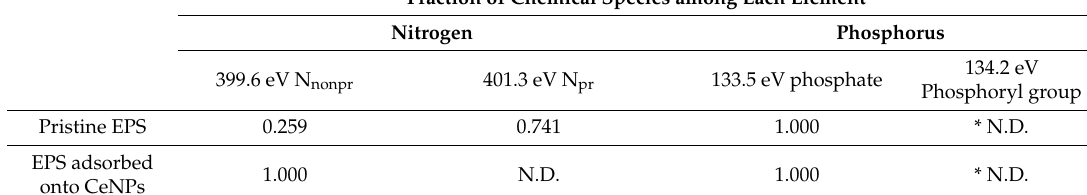
Table 5. Summary of XPS analysis of the speciation of C, O, N, and P in pristine EPS and EPS adsorbed onto CeNPs reacted with EPS. After deconvolution, the intensity of each peak was integrated and normalized to the total integration of each element. *N.D. represents “not detected”.